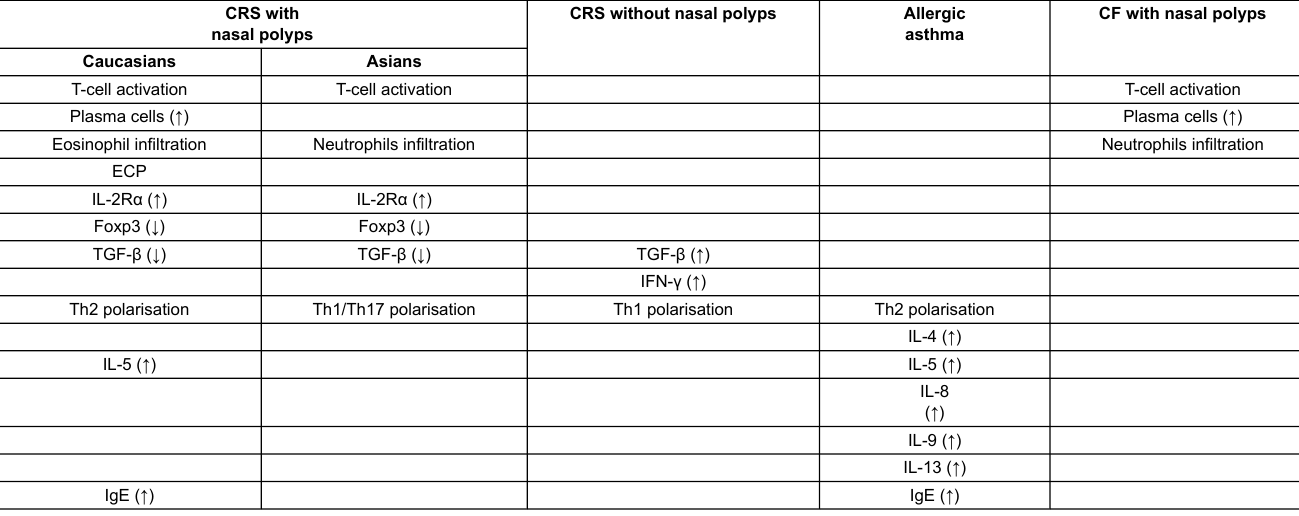
Table 1: Differentiation of the unified airway diseases based on the expression levels of inflammatory cell mediators CRS with nasal